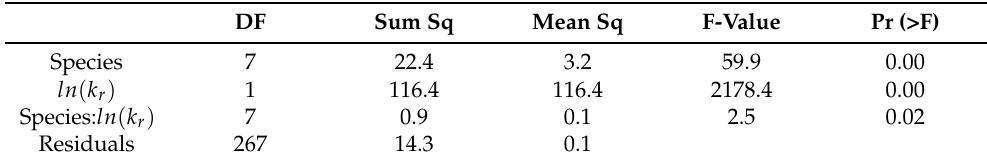
Table A2. ANOVA of a linear model ln ( M a ) i = β 0 + β 1 × Species ln ( k r ) i + (cid:101) i